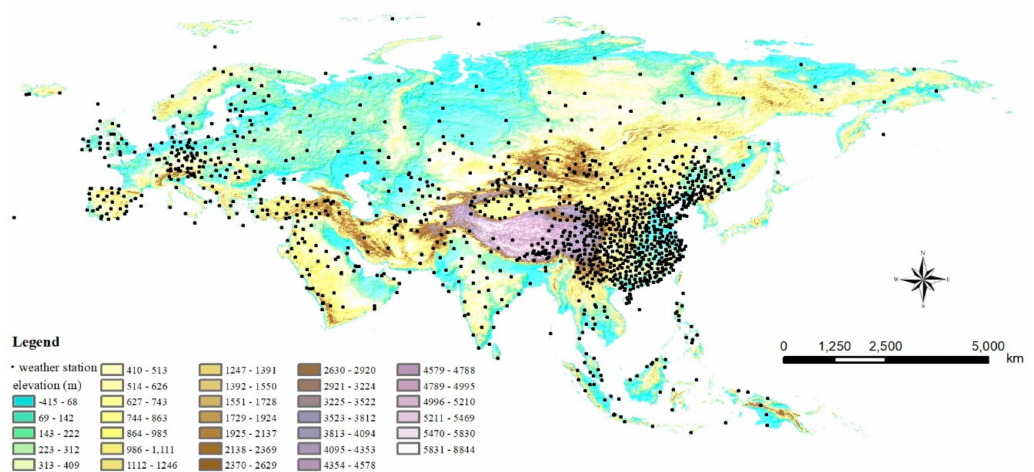
Figure 1. Digital Elevation Model (DEM) data and 1360 weather stations in